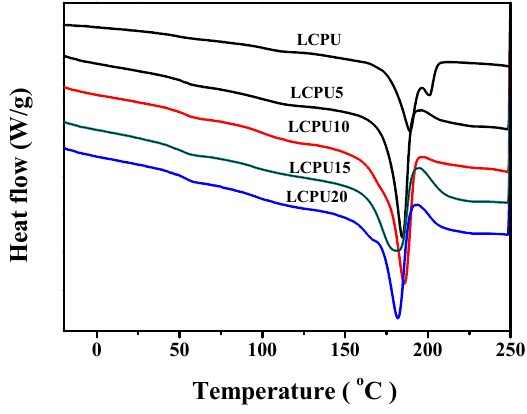
Figure 5. Differential scanning calorimetry (DSC) curves: LCPU, LCPU5, LCPU10, LCPU15, and LCPU20.